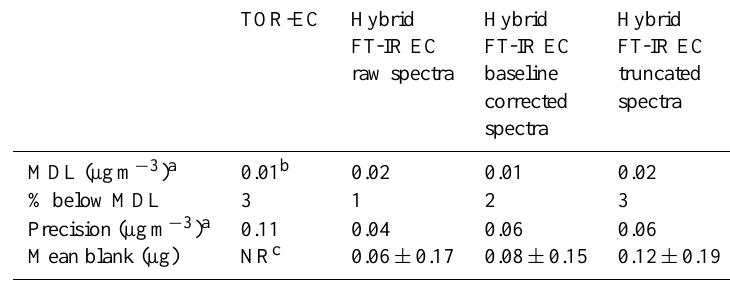
ond percentile for the truncated case. The precision is on the same order for all three spectral